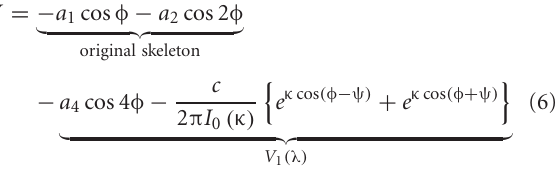
FIGURE 4 | Learning 90 ◦ for initially bistable participants. Top : potential landscape, V solid, V 1 ( λ ) dashed; bottom : phase space portrait; middle : bifurcation diagram. With increasing λ , the unstable fixed point around 90 ◦ (dashed line) shifts towards anti-phase and near λ = 2 a saddle-node